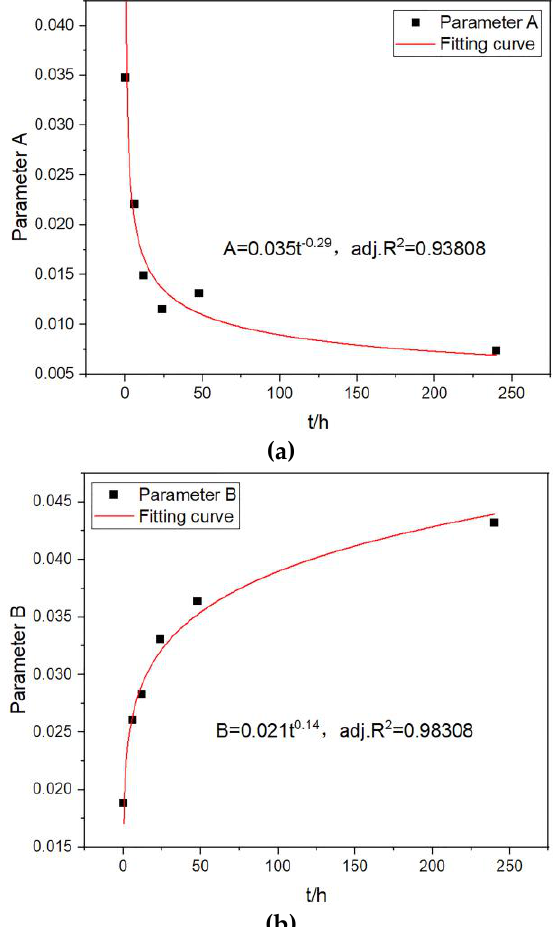
Figure 6. ( a )Temperature ≤ 70 °C . ( b )Temperature > 70 °C . A and B values change with time. Figure 6. ( a ) Temperature ≤ 70 ◦ C. ( b ) Temperature > 70 ◦ C. A and B values change with It can be seen that the value of A decreases gradually with an increase in ATO time.